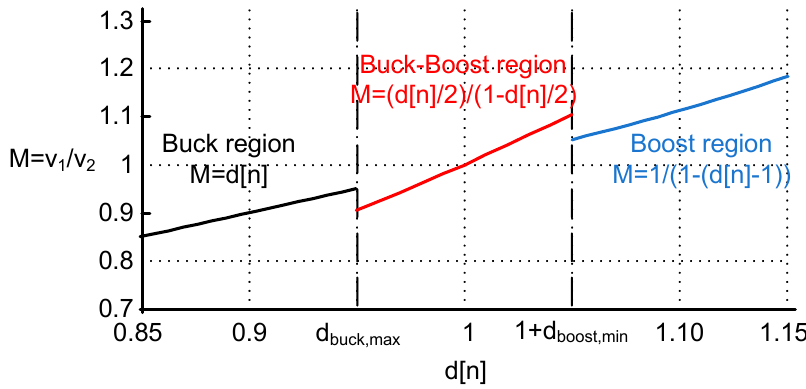
Figure 5. Conversion ratio M as a function of d[n] using the mapping in (11) (Buck-Boost).